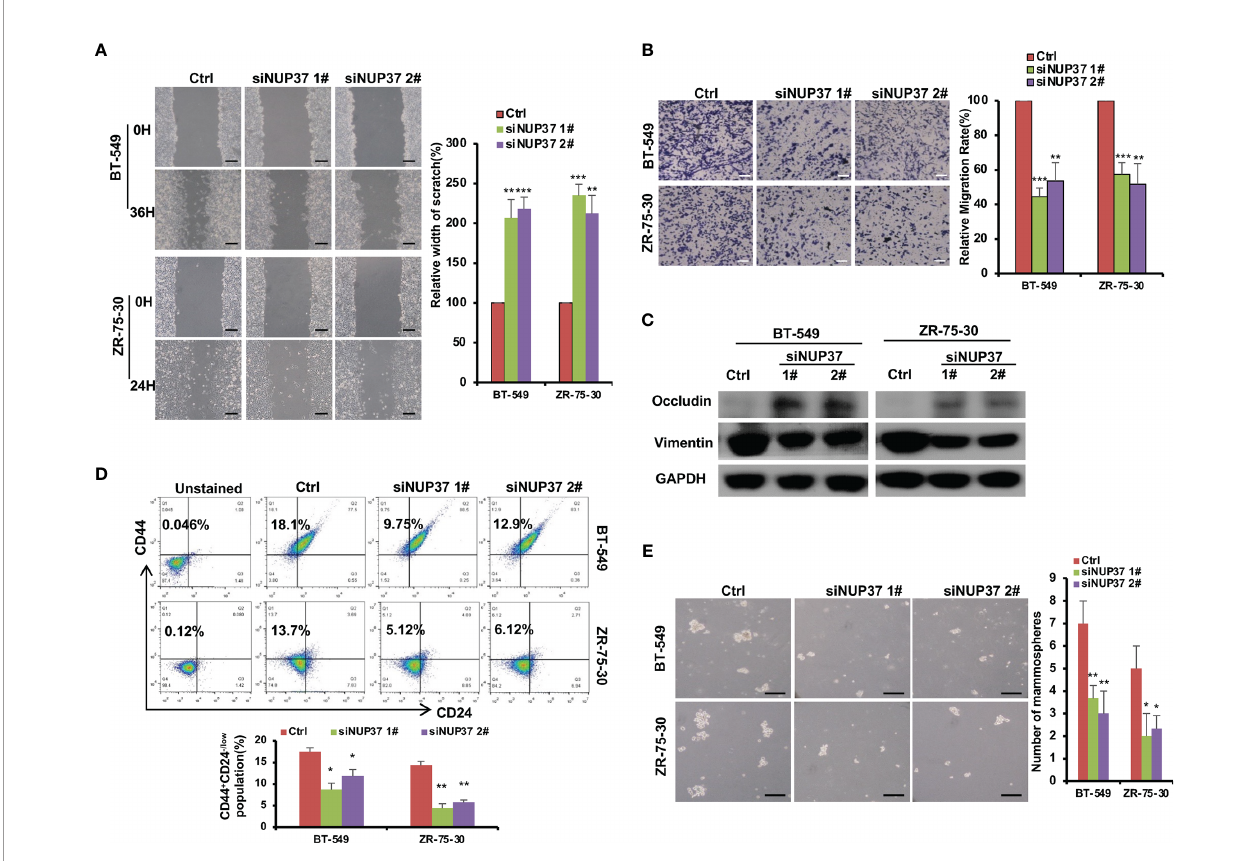
FIGURE 5 | NUP37 knockdown attenuates BRCA cell migration. (A) Scratch assays of BT-549 and ZR-75-30 cells transfected with siNUP37 or siRNA control for 36h and 24h, respectively. Images and Statistical data are shown. Scale bar, 300 m m. (B) Transwell assays of BT-549 and ZR-75-30 cells transfected with siNUP37 or siRNA control for 36h and 24h, respectively. Representative images are shown, and the migrated cells were counted. Scale bar, 200 m m. (C) Western blot analysis of EMT marker protein levels in BT-549 and ZR-75-30 cells transfected with siNUP37 or siRNA control for 72 h. GAPDH was used as a loading control. (D) After transfected with siNUP37 or siRNA control for 72 h, fl ow cytometry analysis of BT-549 and ZR-75-30 cells stained with antibodies against CD44 and CD24 was performed. (E) Mammosphere assay of BT-549 and ZR-75-30 cells transfected with siNUP37 or siRNA control for 7 days. Representative images are shown, and the spheroids were counted. Scale bar, 300 m m. The experiments were performed at least in triplicate, and the results are presented as the mean±s.d. The data were analyzed by Student ’ s t-test (*p<0.05; **p<0.01;